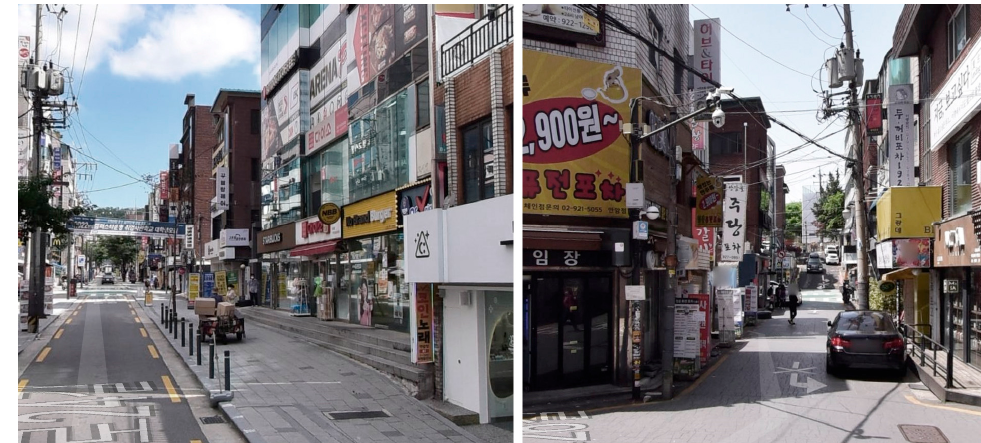
Figure 4. Example of the fully commercialized areas in Seoul within Residential Districts.